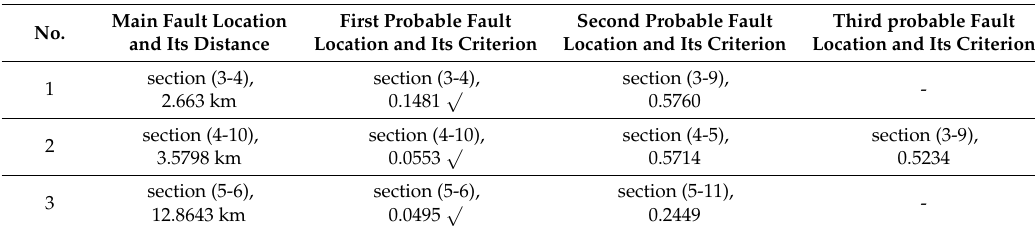
Table 2. Determining main fault section in different distances with zero resistance.